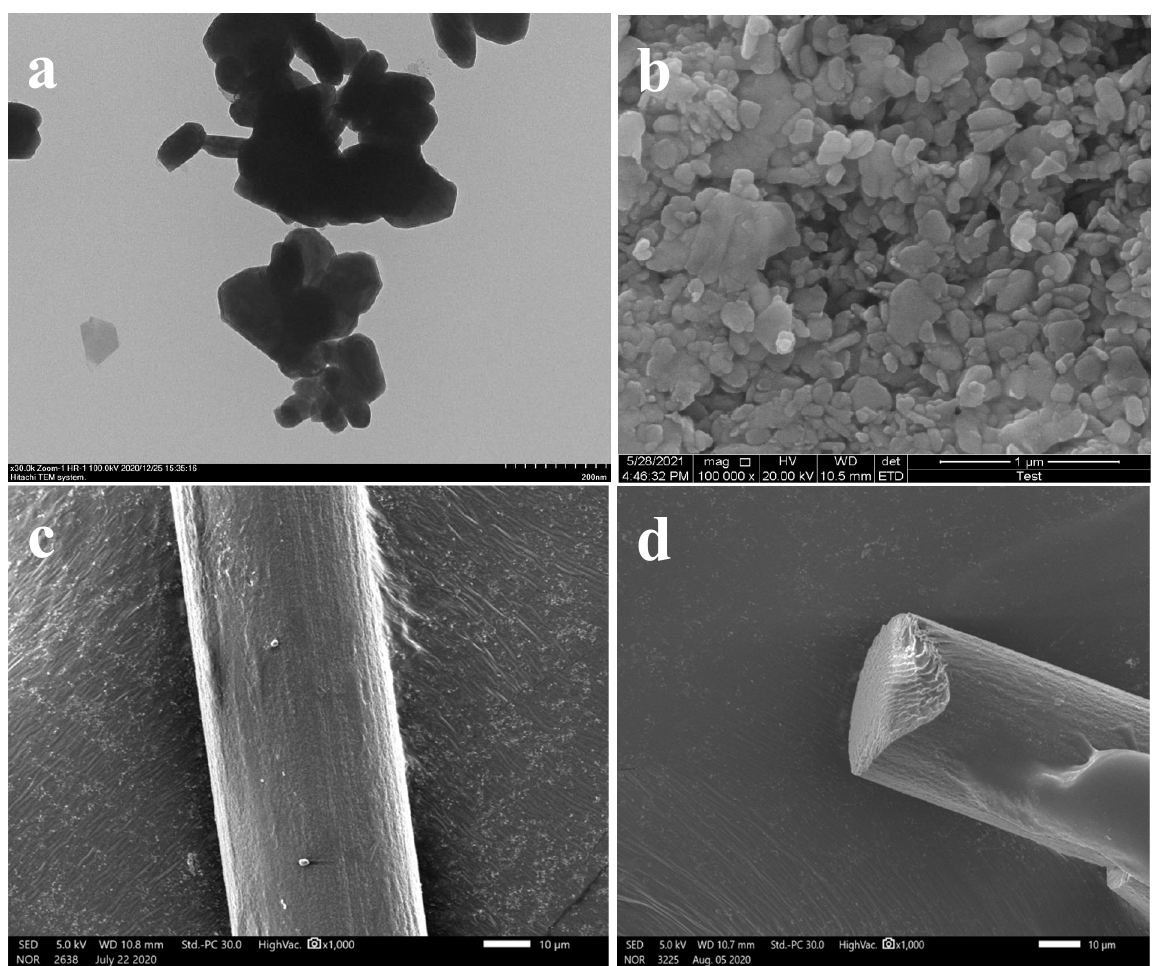
Figure 1. ( a ) TEM image of MoS 2 nanoparticles; ( b ) SEM image of MoS 2 nanoparticles. SEM images of 2 wt% RSF/MoS 2 NPs hybrid fibers; ( c ) surface structure; ( d ) internal structure.